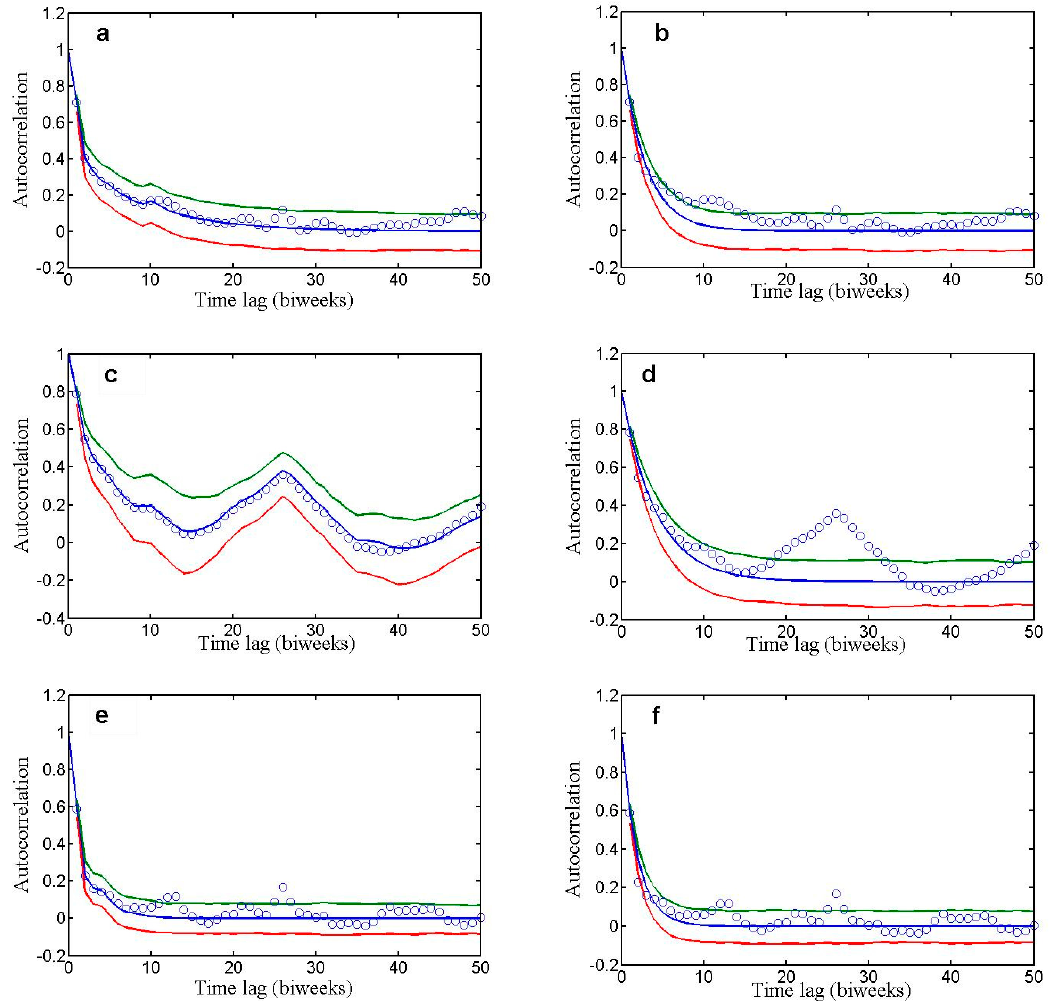
Figure 2. Autocorrelation functions (ACFs) of the original time series and AR (1) fitted processes and better fitted ARMA processes. In x-axes is the time lag (1 unit = two weeks). Circles are the ACFs of the time series (transformed as explained in the text), the blue line the ACF of the fitted process, and red and green lines the 95% confidence limits of the fitted process ACF. ( a ) Discharge AR (9), ( b ) discharge AR (1), ( c ) sodium AR (34), ( d ) sodium AR (1), ( e ) sulfate AR (3), ( f ) sulfate AR(1).